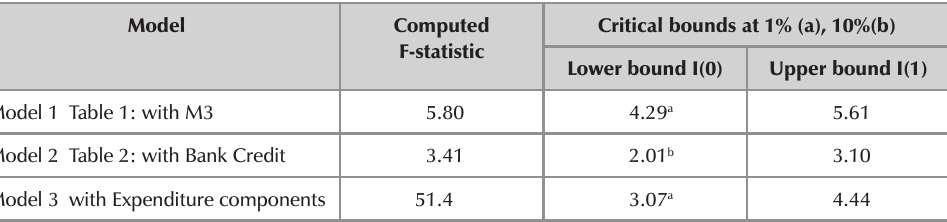
Model 1 Table 1: with M3 Model 2 Table 2: with Bank